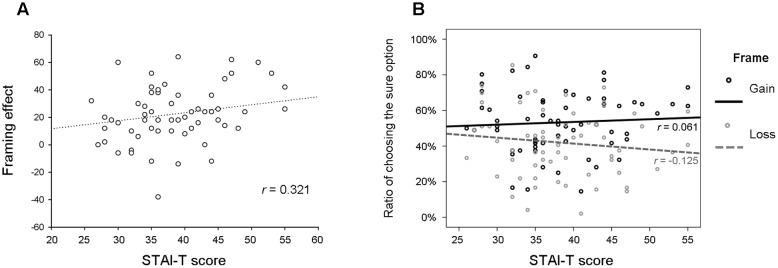
(A) A scatter plot of the correlation between STAI-T score and the framing effect size (p = 0.010). (B) A scatter plot of the correlations between STAI-T score and the ratio of choosing the sure option in the gain frame and the loss frame conditions (ps > 0.327).